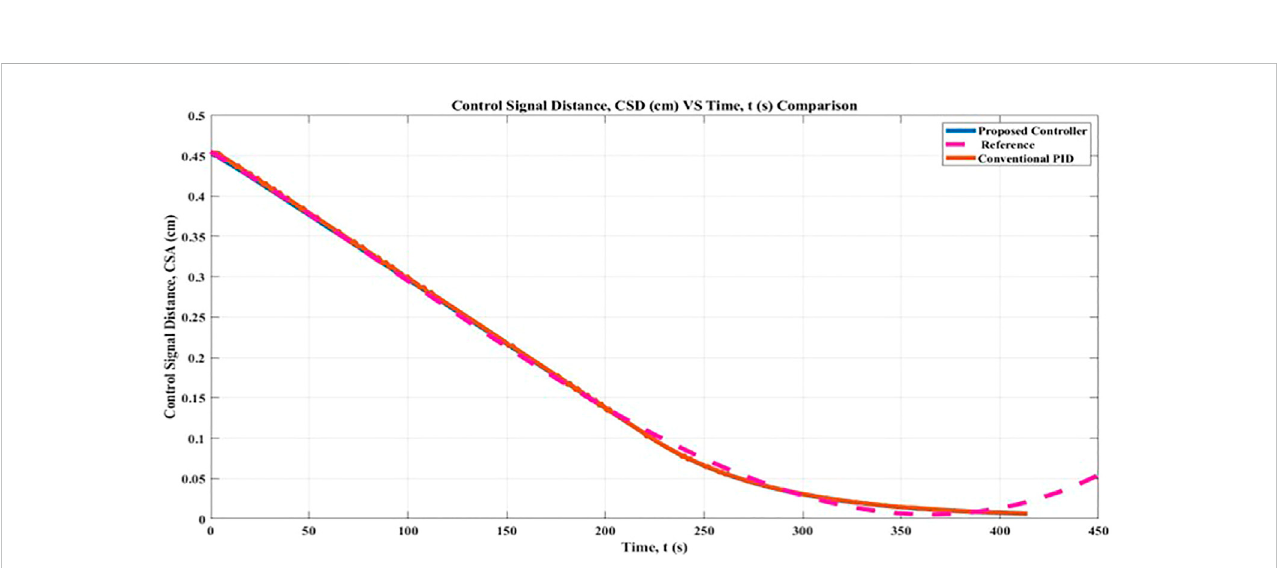
FIGURE 9 Control Signal Distance (CSD) comparison